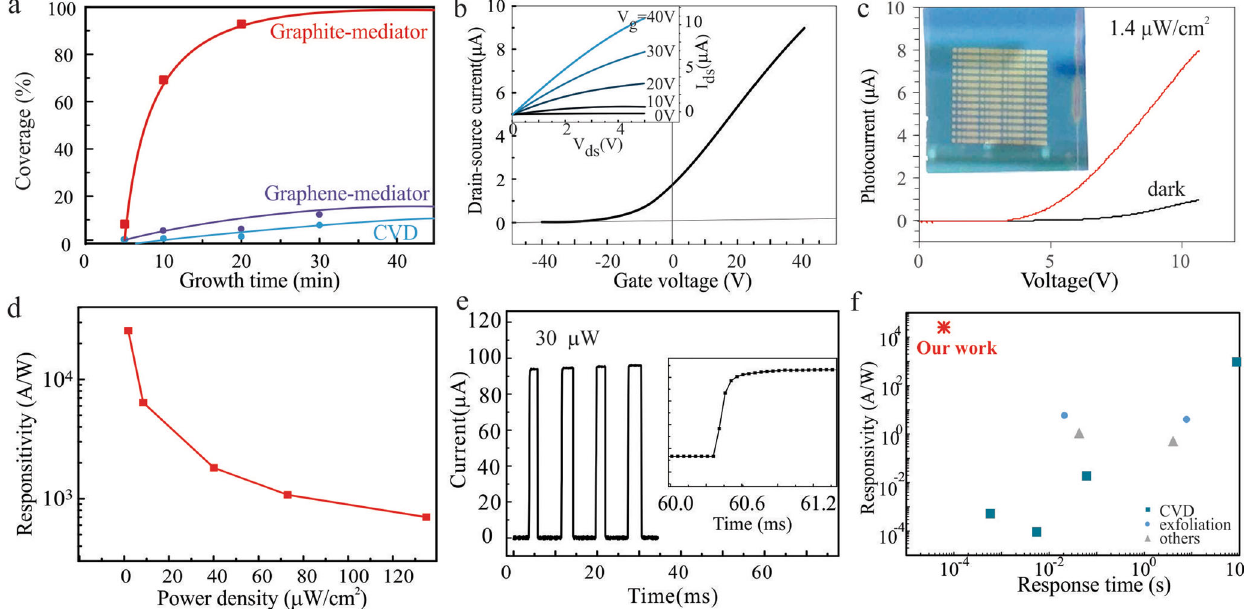
Fig. 5 Application of mediator-grown WS 2 . a Comparison of achievable coverage with and without different mediators. b Transconductance of FET fabricated from mediator-grown WS 2 , (inset) drain-source current-voltage characteristics at different gate voltages. c Current- voltage characteristics of graphite mediator-grown WS 2 in dark and illuminated conditions, (inset) photograph of device array. d Power-dependent photoresponsivity, e current response under pulsed light illumination, (inset) closeup of rising fl ank. f Comparison of device performance to reported values for WS 2 (more details and references in Supplementary Table